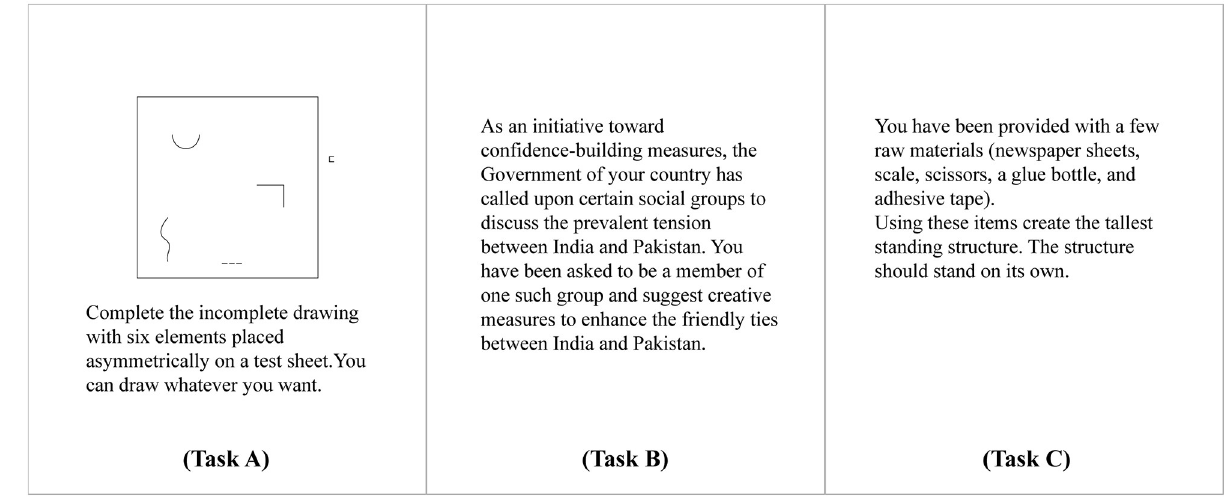
Fig 1. CPS group